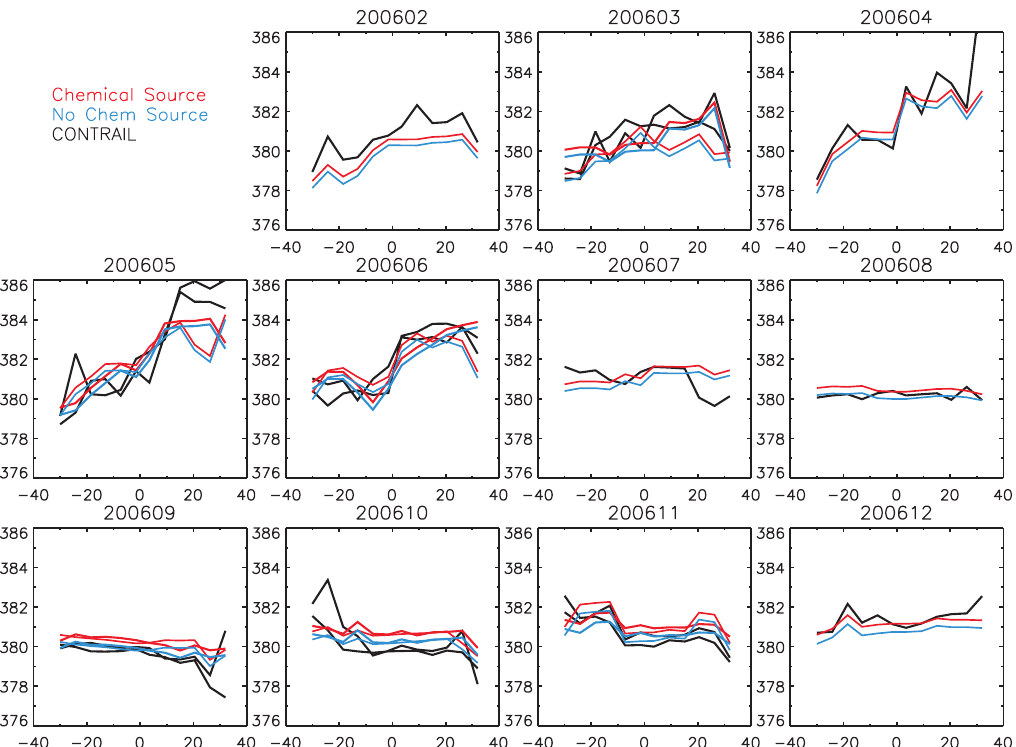
Fig. 16. Comparison of model and CONTRAIL (black) CO 2 (ppm) as a function of latitude for individual flights between Japan and Australia. Model simulations with the chemical source (red) and without it (blue) are sampled at the CONTRAIL locations and times ( ± 3h). For months with two flights plotted on the same panel, dotted lines denote the second flight.